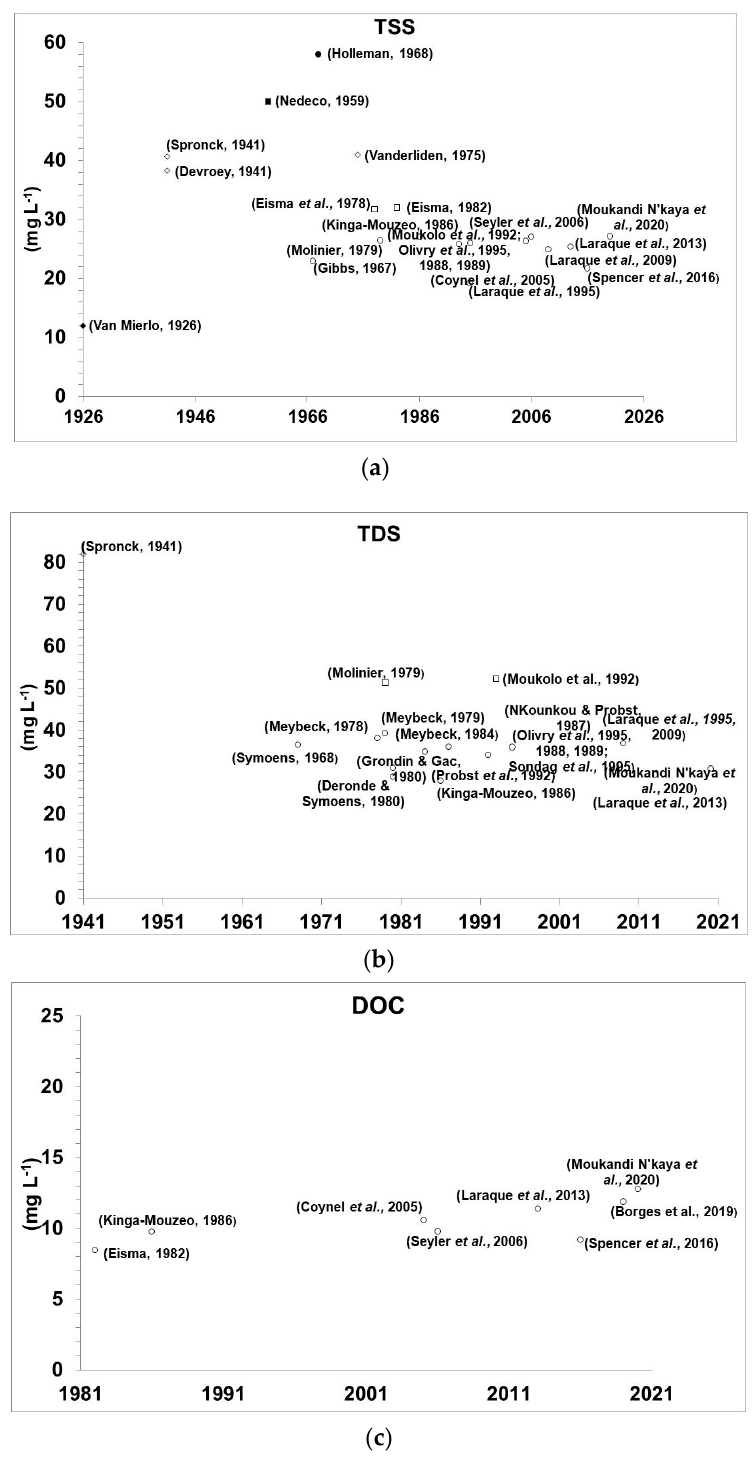
Figure 13. ( a ) TSS, ( b ) TDS, and ( c ) DOC concentrations versus time on the Congo River at BZV/KIN from different authors. Table 2. Chronological compilation of TSS, TDS, and DOC concentrations since the beginning of the studies on Congo River quality at Brazzaville/Kinshasa gauging stations.